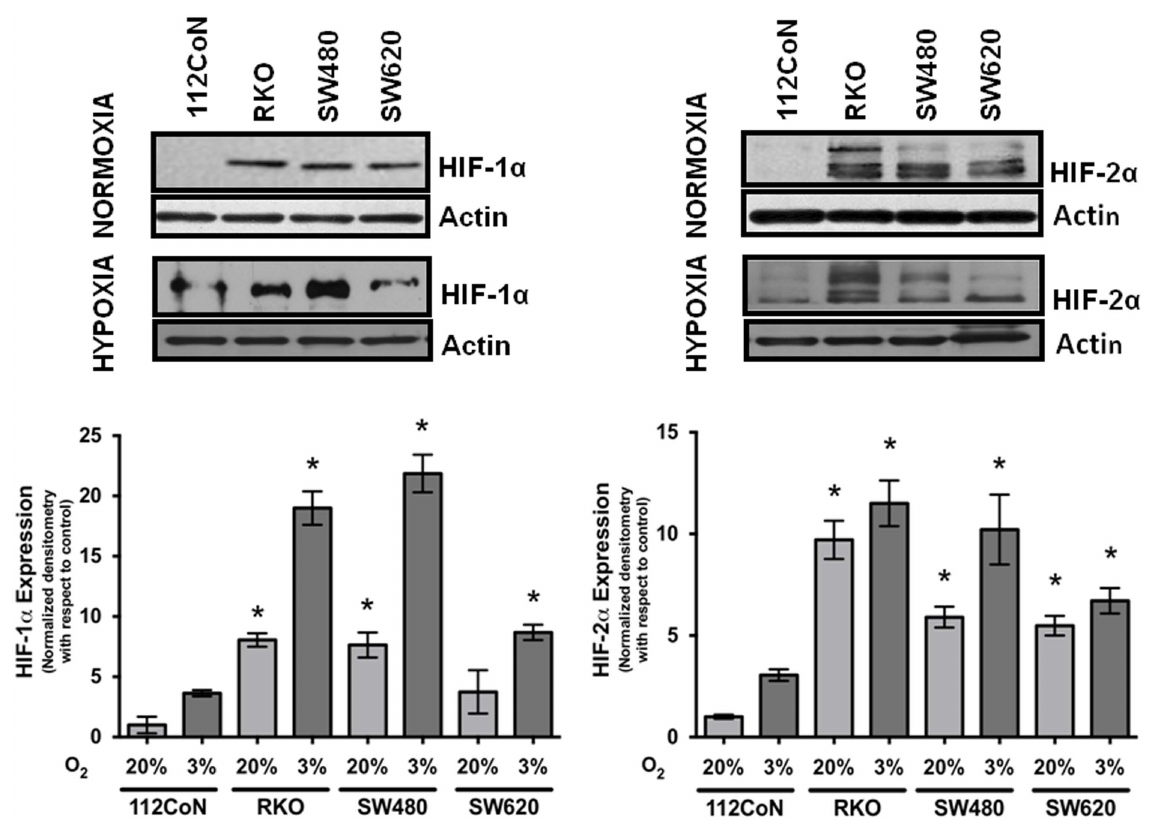
Figure 1. HIF-1 a and HIF-2 a are co-expressed in colon cancer cells but not in non-malignant cells under normoxic conditions. Normal colon (112CoN) or colon cancer cells were cultured under normoxia (20% O 2 ) or hypoxia (3% O 2 ) for 12 h. Total cell extracts of the colon cell lines were prepared, and the samples were subjected to 10% SDS-PAGE and transferred onto nitrocellulose membranes. An immunoblot analysis was performed using anti-HIF-1 a or anti-HIF-2 a antibodies as indicated in the figure, and developed using a horseradish peroxidase-conjugated second antibody. Actin antibody was used to control for equal loading. A densitometric analysis was performed to estimate the levels of HIF-1 a and HIF-2 a expression, which were normalized to the corresponding expression levels in non-malignant 112CoN cells. All of the assays were performed in triplicate, and the data represent the means 6 SEM from at least three independent assays. *p , 0.05.